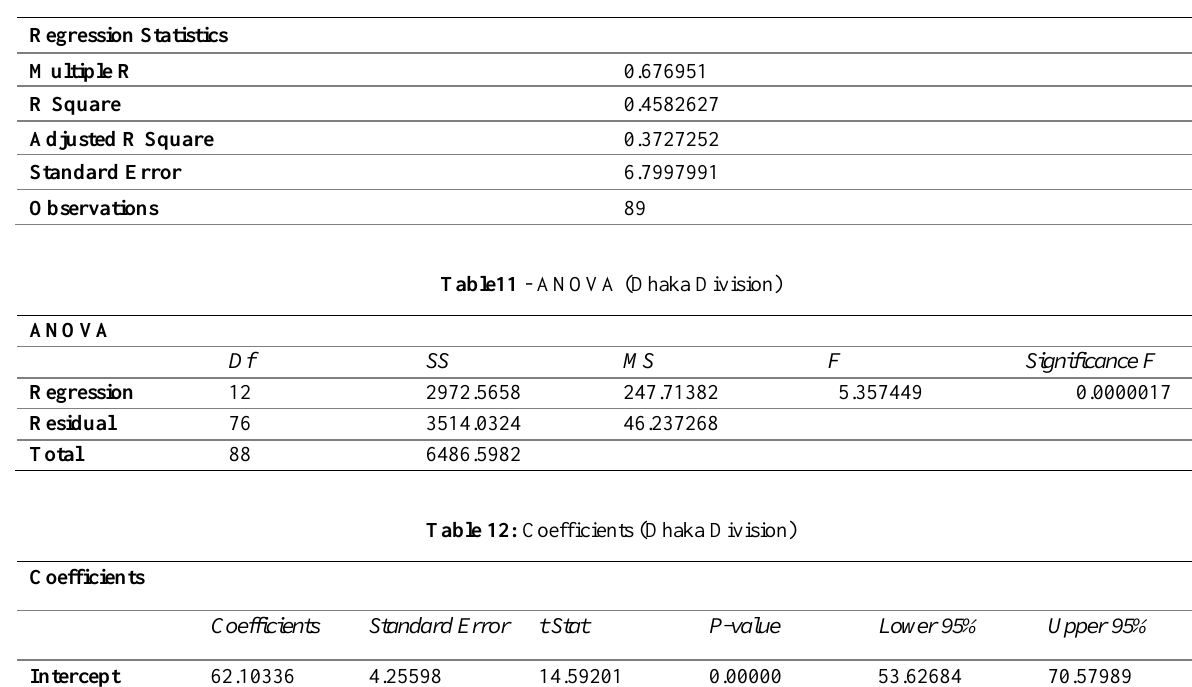
Table 10: Regression Statistics (Dhaka Division)